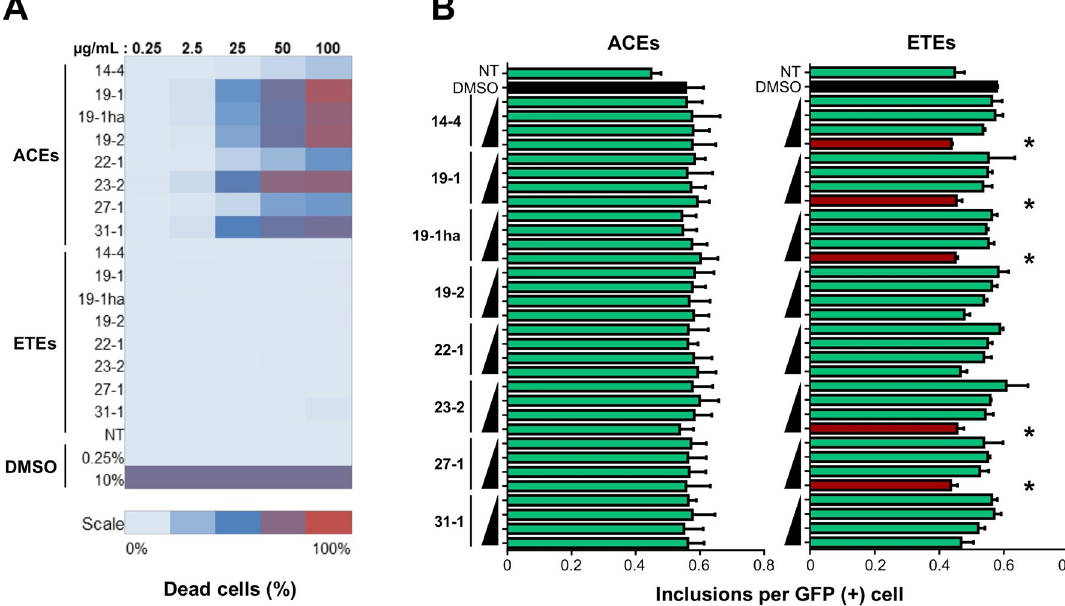
Fig 2. Treatment with extracts from different genotypes of U . molinae fruits exerts differential effects on cell viability and the number of polyQ 79 -EGFP inclusions in HEK293 cells. The analysis was performed in the cellomics platform of automated fluorescence microscopy. (A) For the cell viability analysis, cells were seeded and then treated with increasing concentrations of each extract. After 24 h, cells were treated with 7-AAD and images were acquired with the cellomics platform. 7-AAD-stained cells were quantified using the General intensity measurement tool. Data was acquired using the HCS Studio 1 software. (B) For the analysis of the effects over polyQ 79 - EGFP inclusions, cells were transfected and then treated with increasing concentrations of each extract. A range of concentrations from 3.1 to 12.5 µ g/mL were analyzed for ACEs, except for ACE 14–4 (12.5 to 100 µ g/mL). For ETEs, concentrations from 12.5 to 100 µ g/mL were analyzed. After 24 h, images were acquired in the cellomics platform and GFP (+) protein inclusions were quantified using the spot detector application. Data was acquired using the HCS Studio 1 software. Results are the mean ± SEM of 3 independent experiments. Statistically significant differences were detected by one-way ANOVA and Tukeys multiple comparisons considering DMSO as control ( � = p <